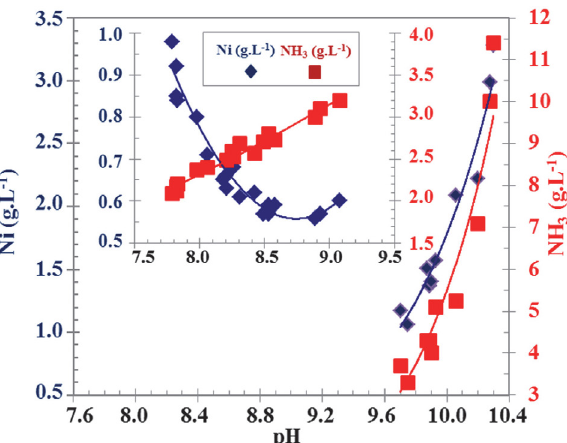
Figure 5. Profile of nickel and ammonia dissolved versus pH at 25 °C in the column-industrial (Stage 03). Ni/S 1.2, Ni/[SO 42– ] 2.5, Ni/ [S 2 O 3 2– ] 1.7, NH 3 /CO 2 1.63.